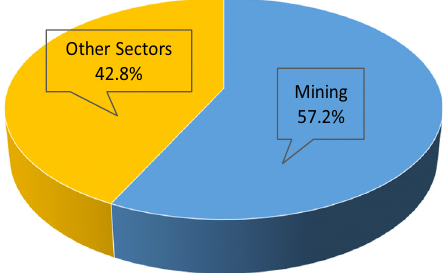
Figure 5: Proportion of negatively concluded EIA applications of mining sector versus other sectors.